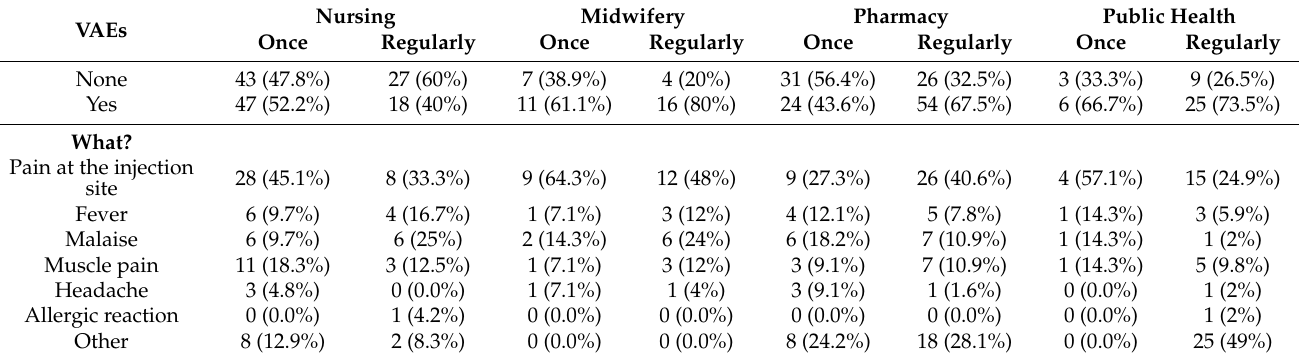
Table 6. Vaccine adverse events reported following flu vaccination, according to major and frequency of vaccination.